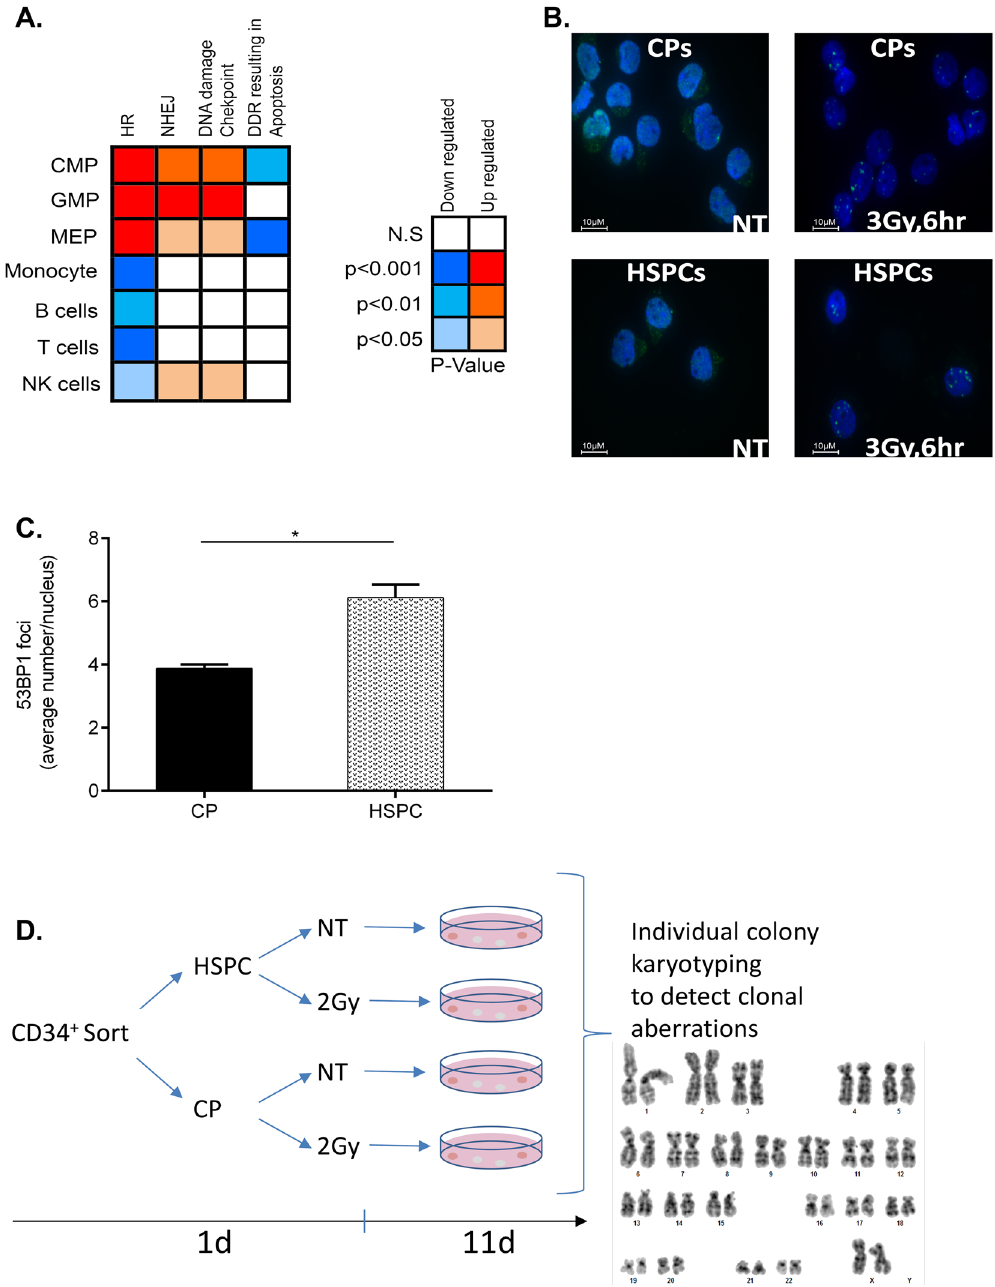
Figure 5. DNA repair and DDR gene expression, DSB marker and genome stability analyses. (A) left panel: relative expression of transcripts related to DNA repair, DDR checkpoint and apoptosis pathways in CPs (CMP, GMP and MEP) and mature blood-derived cells (B, T and NK) in comparison to HSPCs colored accordingly to the significance of the changes. right panel: color scheme description with blue colors for decreased expression and red colors indicative of increased expression relative to HSPCs along with the corresponding p values. (B) CD34 + cells were sorted into HSPC and CP fractions. Representative immunofluorescence staining visualized for 53BP1 (green) and DNA (blue) in HSPCs and CPs 6 hr after 3 Gy IR. (C) Average number of 53BP1 foci per cell in CPs and HSPCs. n = 3 experiments; Represented are mean values ± SD; * p < 0.05. At least 100 nuclei were analyzed in each experiment. (D) Workflow for the karyotype analysis of irradiated HSPCs and CPs. Freshly isolated CD34 + cells were sorted for HSPC and CP fractions, exposed or not to IR (2 Gy) and then plated at low density in methylcellulose to allow colony formation. Individual colonies were isolated for metaphase preparation and karyotype analysis (Table 1, and Supplementary Table